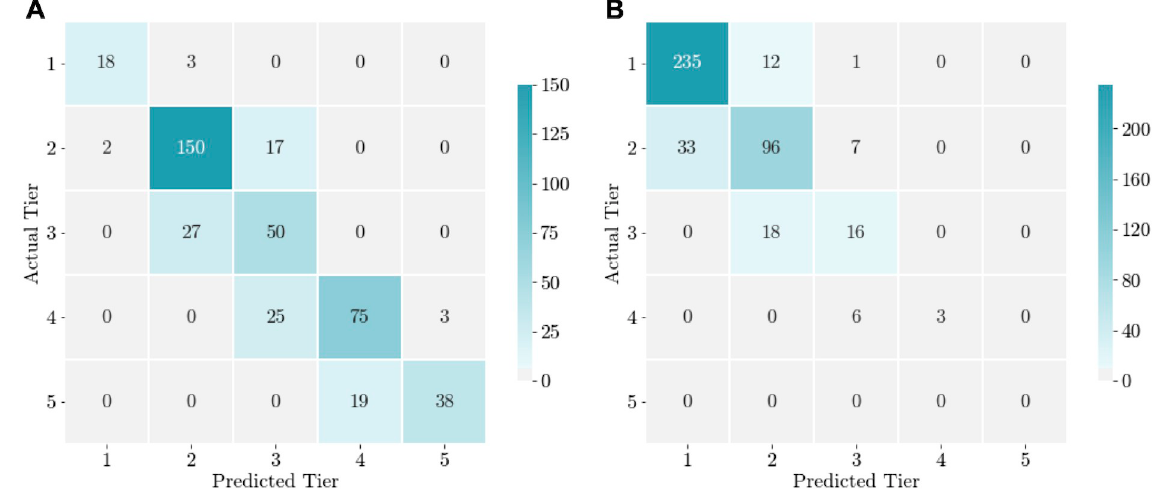
Fig 4. Confusion matrices illustrating the accuracy of the severity categorization of our model’s predictions of (a) new cases and (b) proportion of COVID-19 tests that are positive. The sample covers November 1 to December 31, 2020 ( n = 427). Columns represent the model-predicted severity for the following week, categorized into the five tiers, where Tier 1 is the least severe and Tier 5 is the most severe, and rows represent actual values of epidemic severity for the following week.